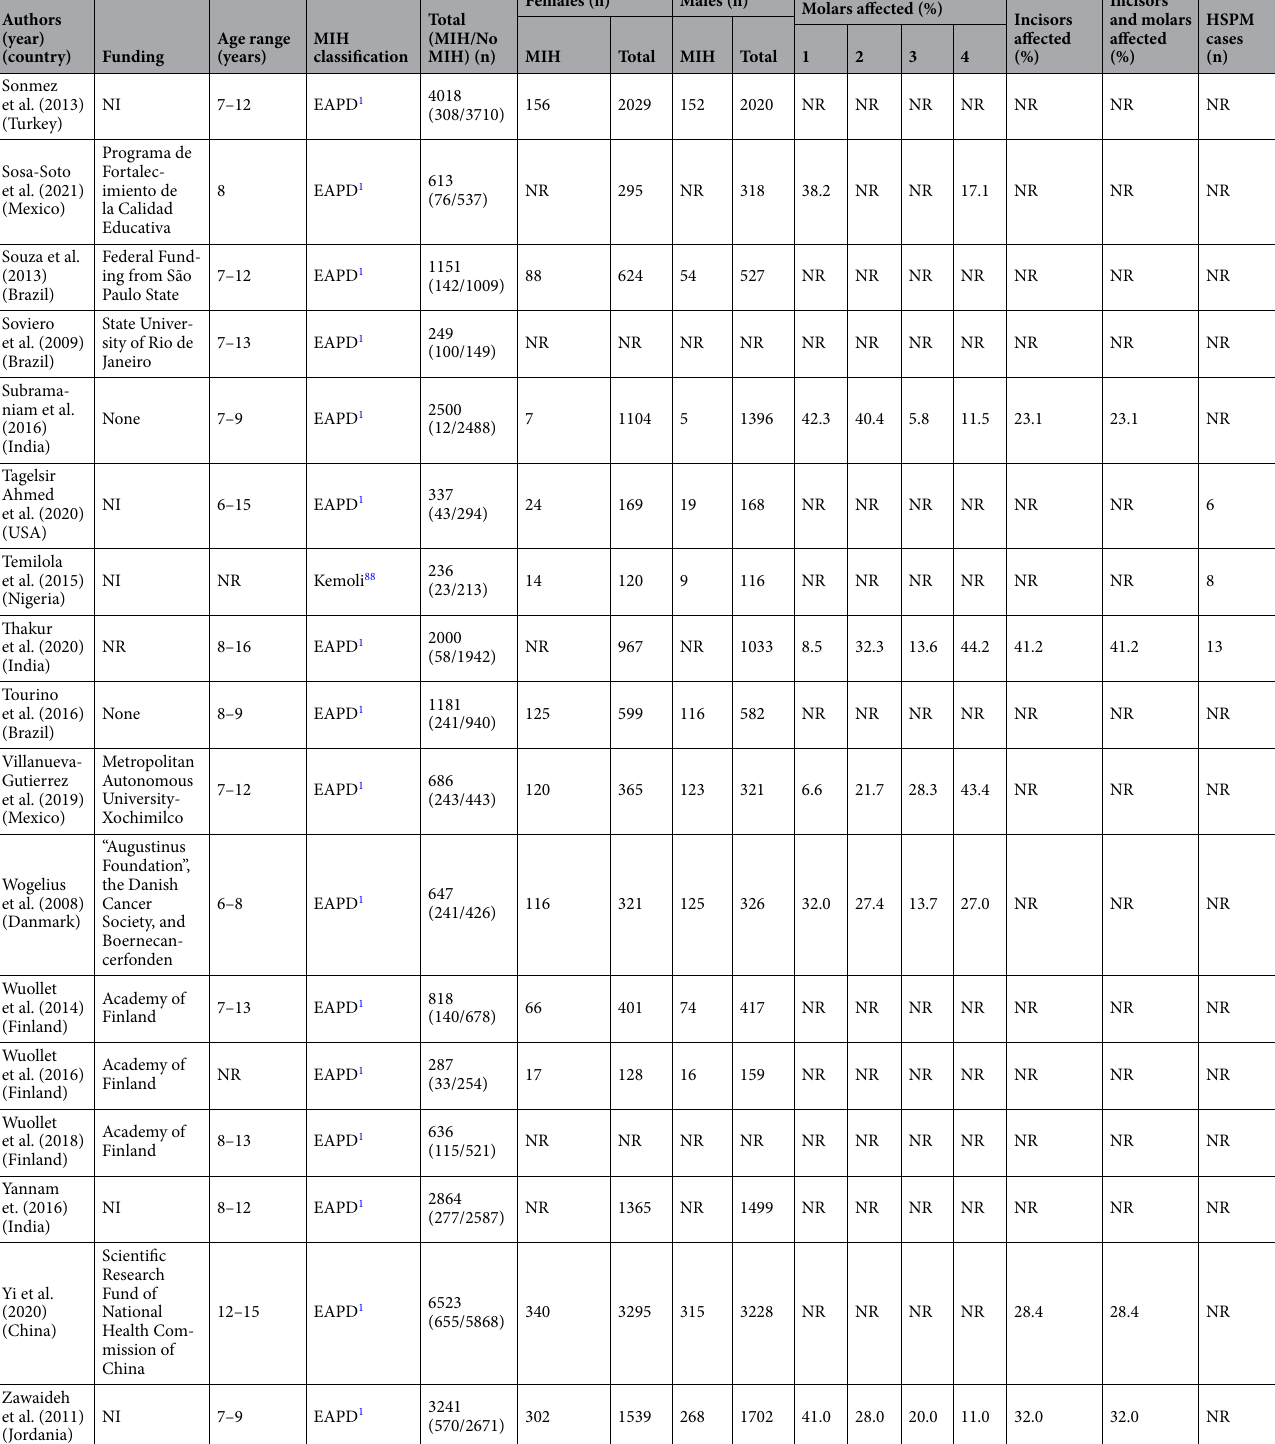
Table 1. Characteristics of the included studies. NR Not reported, NI No information, EAPD European Academy of Pediatric Dentistry (Weerheijm et al. 1 ), mDDE modified Developmental Defects of Enamel